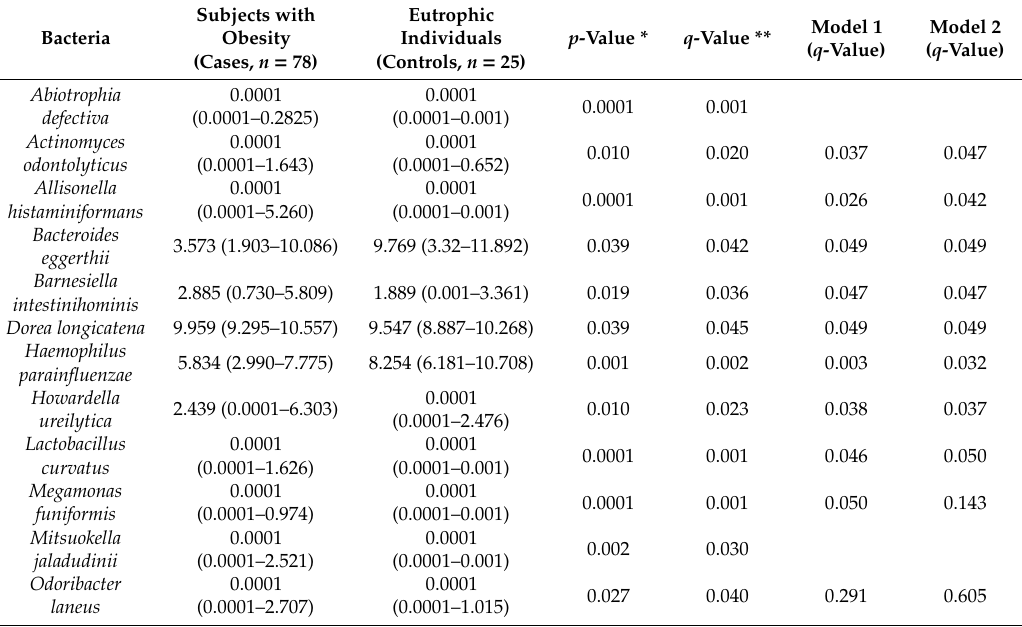
Figure 2. Gut microbiota composition in subjects with and without obesity. Relative abundance of ( A ) Bacterial genera. ( B ) Bacterial species. Differences in bacterial relative abundance at the genus and species levels in cases with obesity and controls with normal weight. Only genera or species whose abundances were significantly different (FDR, q -value < 0.05) are shown. p -values were obtained using Student t -test with the log-transformed variable and raw p -values were corrected by false discovery rate (FDR; q -value). The percentage of occurrence of each taxon is reported as cumulative bar chart. This figure was performed using ploty.com. Table 3. Bacterial species whose abundance is statistically di ff erent between cases with obesity and eutrophic